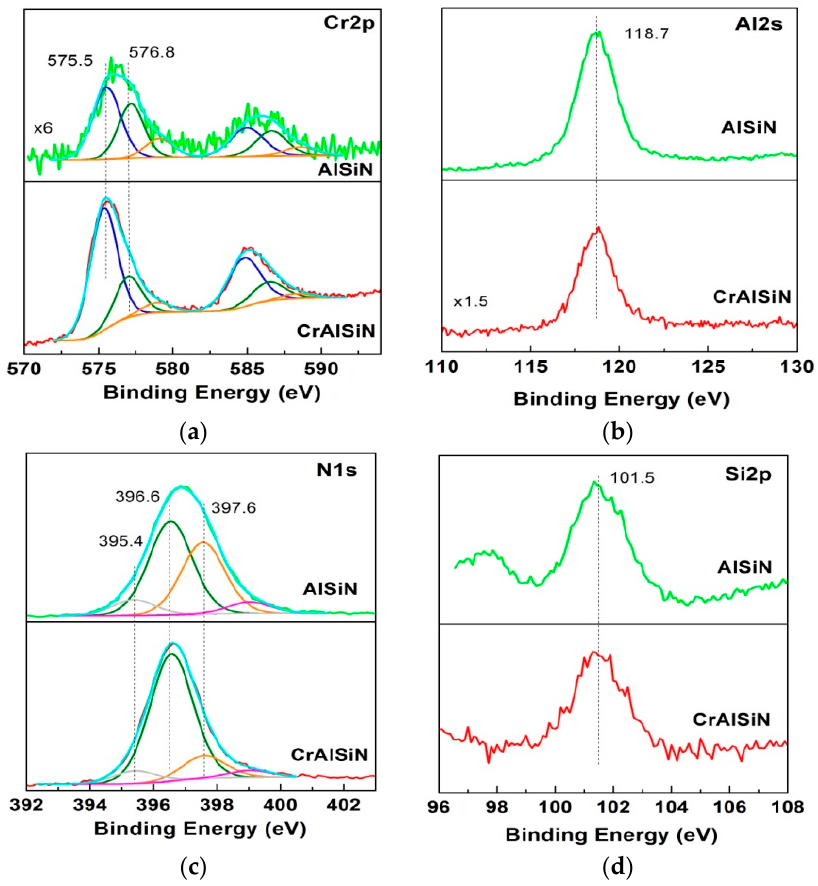
Figure 7. XPS ( a ) Cr2 p , ( b ) Al2 s , ( c ) N1 s , and ( d ) Si2 p spectrta of the CrAlSiN and AlSIN films of the modulated coating.